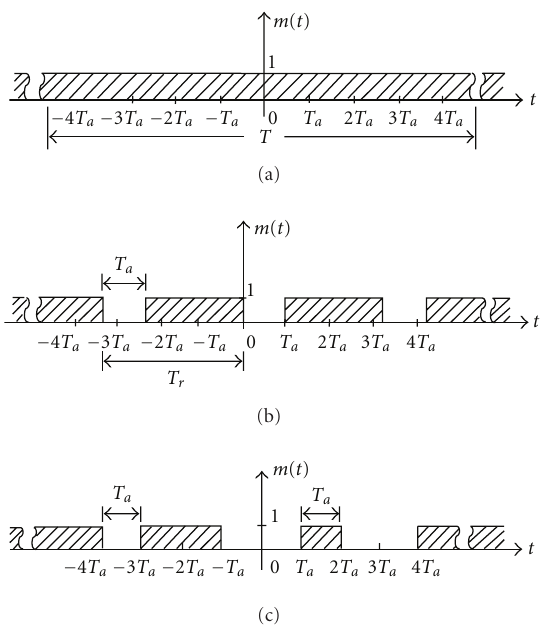
Figure 2: Three blanking models: (a) no-blanking, (b) periodic blanking, and (c) random